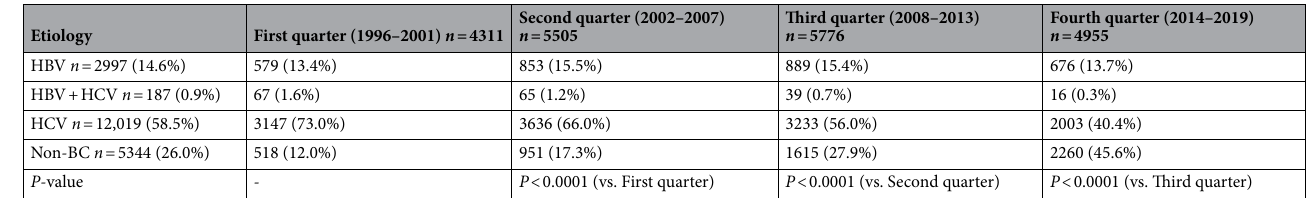
Table 4. Distribution of disease etiology among new hepatocellular carcinoma cases in each quarter. Data are presented as counts (%). Non BC=both hepatitis B surface antigen and HCV-antibody